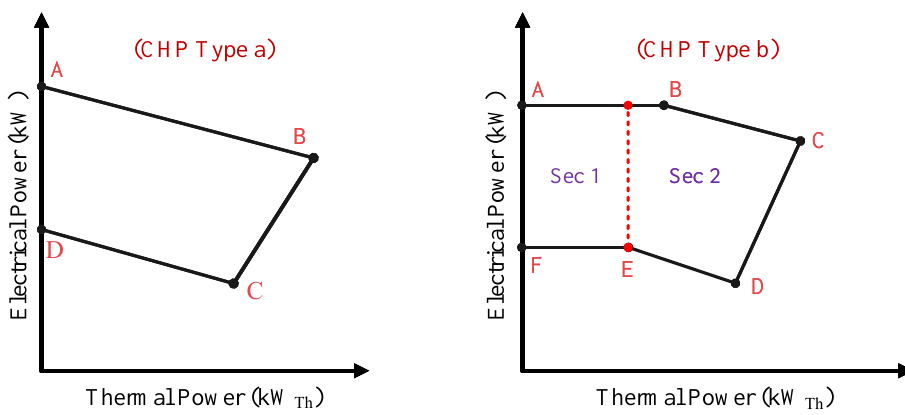
Figure 2. Feasible operational regions of the first and second types of CHP